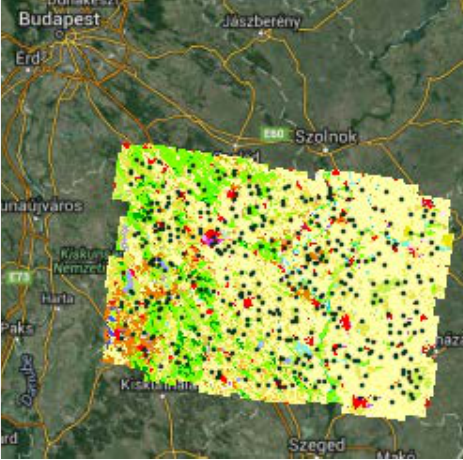
Figure 10. The random distribution of world centres over the area.